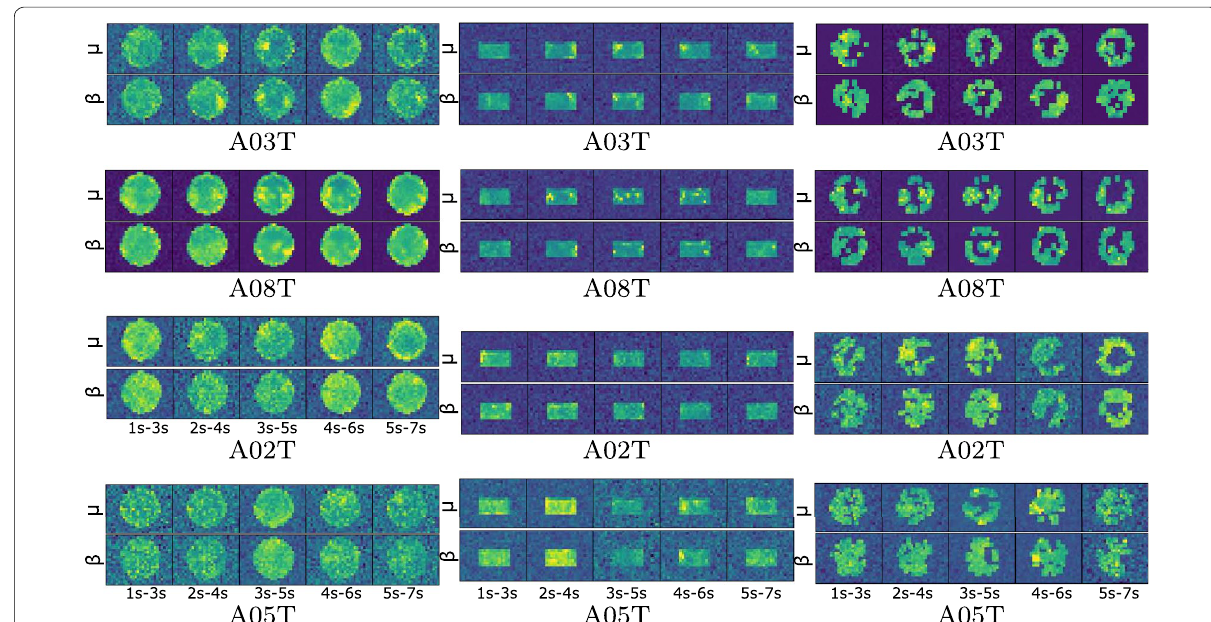
Fig. 4 Individual relevance weights performed by the tuned CWT feature extraction for the bi‑class scenario C : Without spatial dropping (left column), spatial dropping by removing all sensorimotor electrodes out (middle column), spatial dropping by excluding nonrelevant electrodes (right